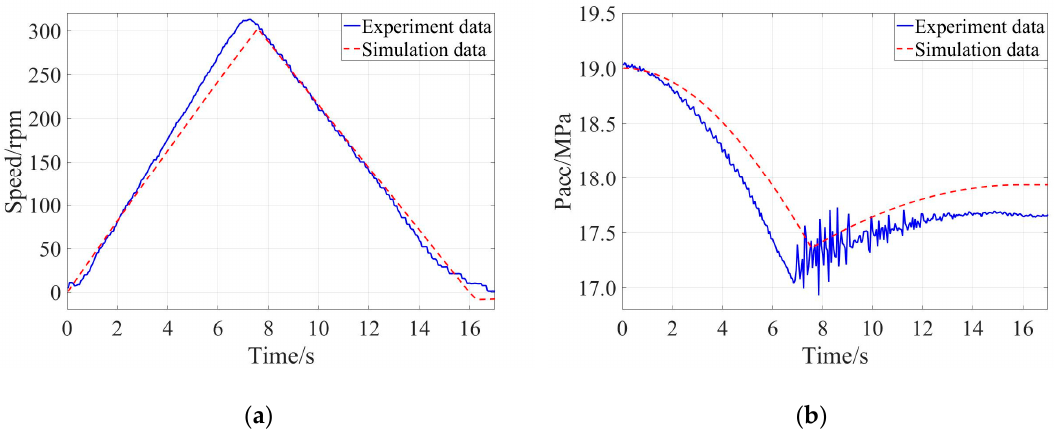
Figure 10. Comparison of the experimental result and simulation result when the braking intensity was 0.35: ( a ) Evolution of speed of the flywheel, ( b ) Evolution of pressure of the accumulator.